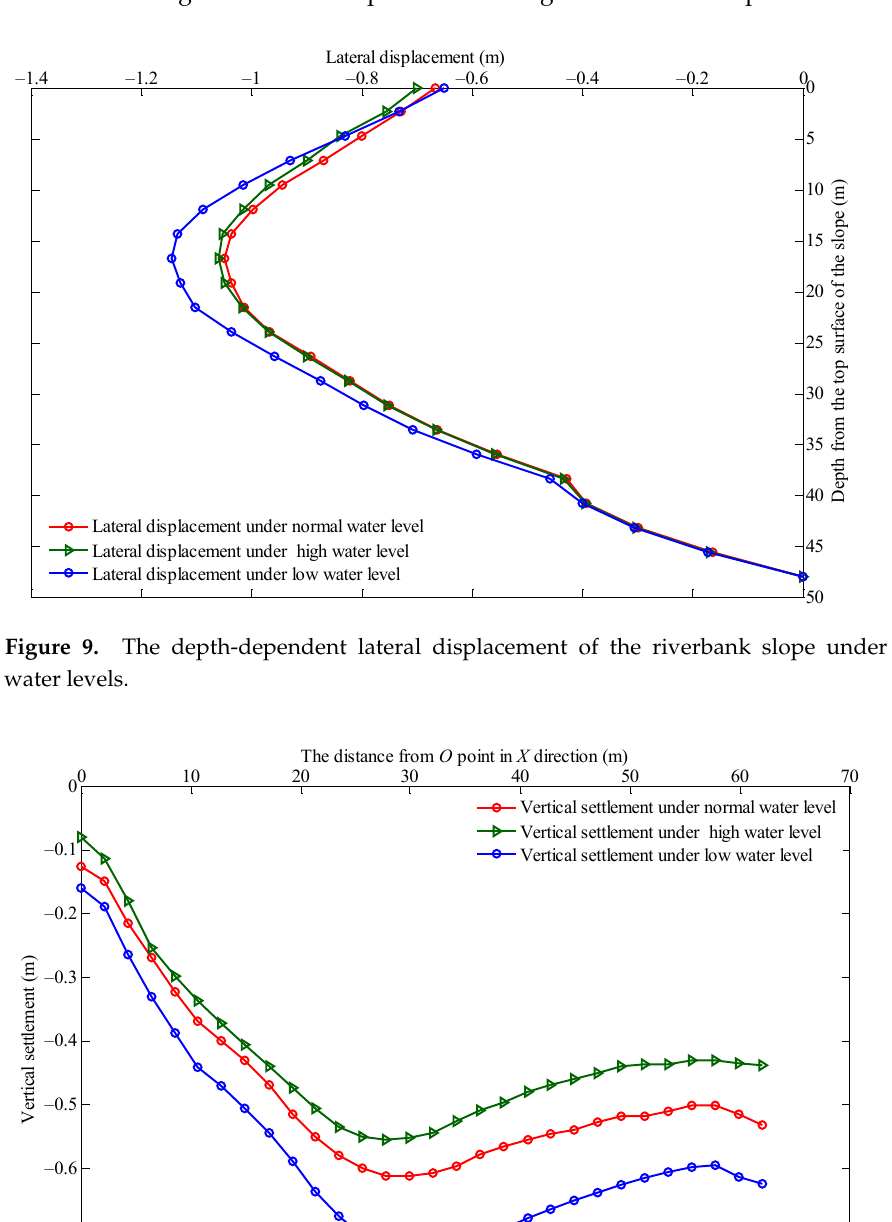
Figure 8. The finite element analysis result. 3.2. Displacement of Riverbank Slope under Different Water Levels